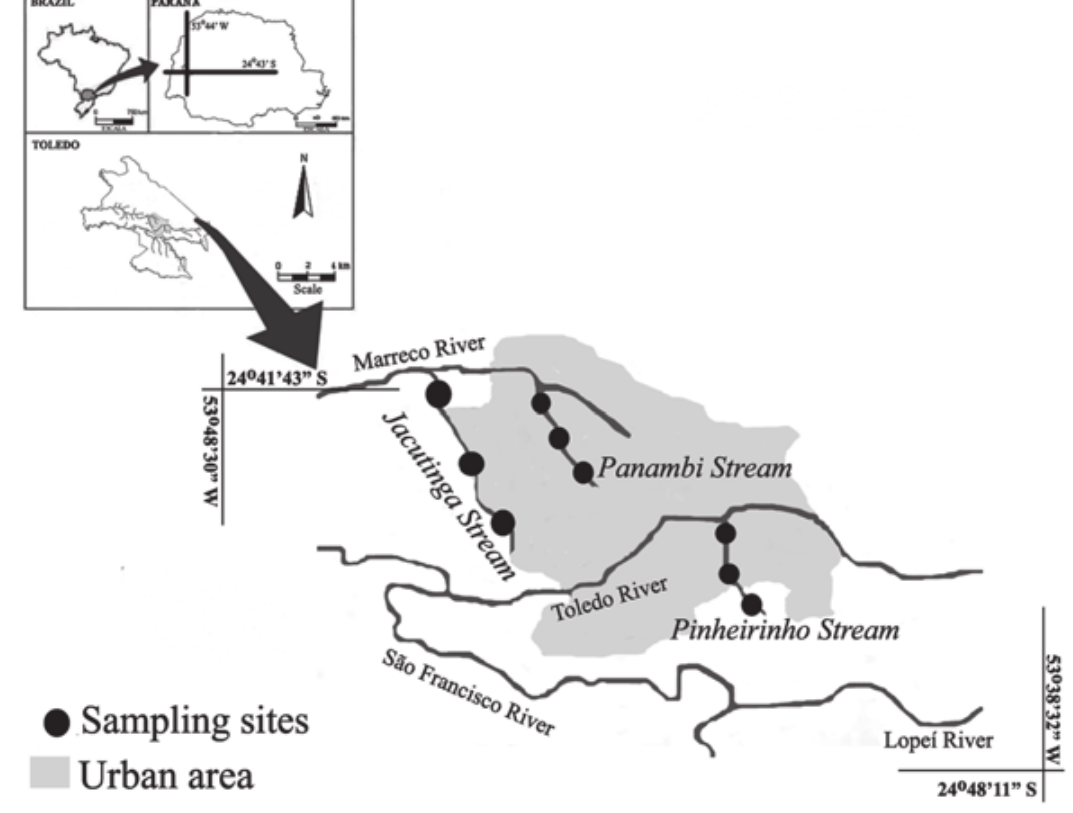
Fig. 1. Sampling sites in three streams located in the city of Toledo, State of Paraná, southern Brazil.